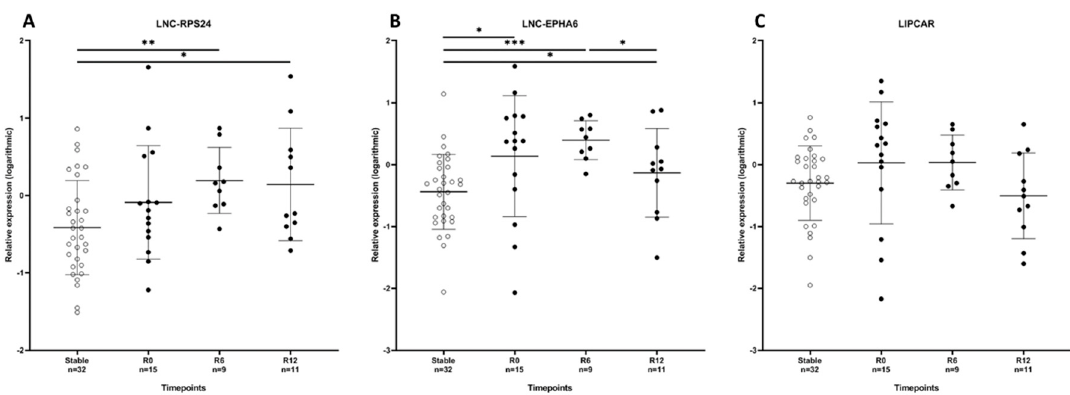
Figure 2. Circulating lncRNA levels are effected by acute rejection. Relative expression of LNC-RPS24 ( A ), LNC-EPHA6 ( B ), and LIPCAR ( C ) in the cross-sectional cohort; kidney recipients with a stable kidney function (Stable; n = 32), kidney recipients with acute rejection at the time of rejection (R0), and 6 and 12 months after rejection (R6 and R12). Data are presented as mean ± SD, * p -value < 0.05, ** p -value < 0.01, *** p -value < 0.001.